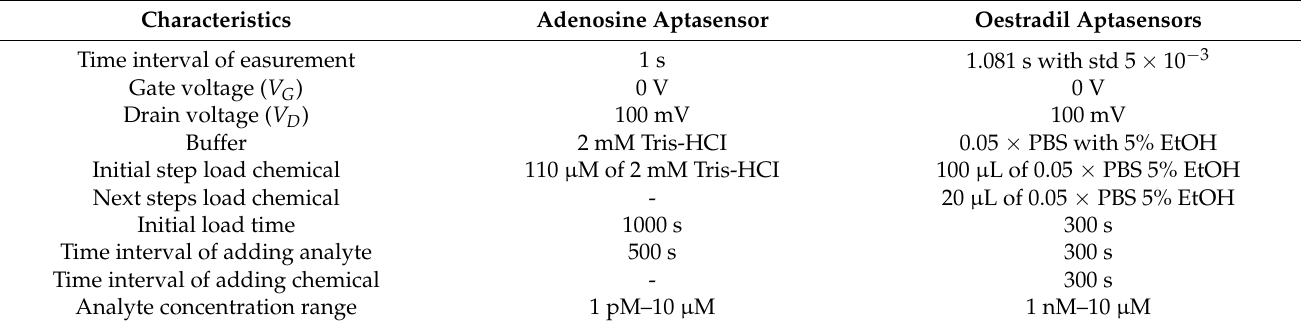
Table 2. Comparison of the sensing protocols of the adenosine and oestradiol aptasensors. Note that the sensing protocols for both the 31-mer and 35-mer oestradiol aptasensors were completely the same. Thus, their relevant information is merged into one